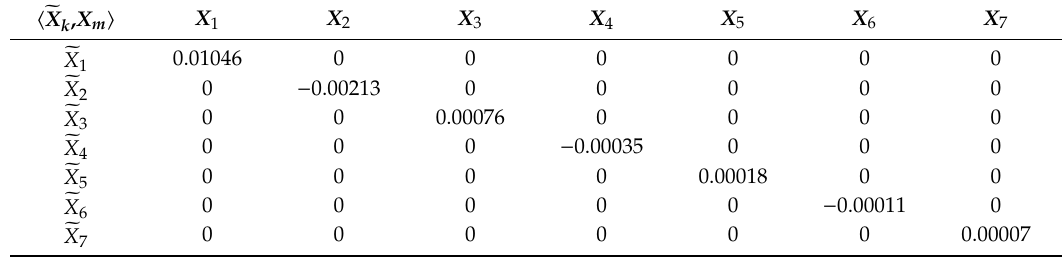
Table 1. The first seven eigenvalues of boundary value problems (10)–(11) for α = 1.47, c = 1.8 and Table 2. Inner product of the first seven eigenfunctions of boundary value problems (10)–(11) and 𝔛 = 1 . functions of the biorthogonal system; α = 1.47, c = 1.8 and X = 1.